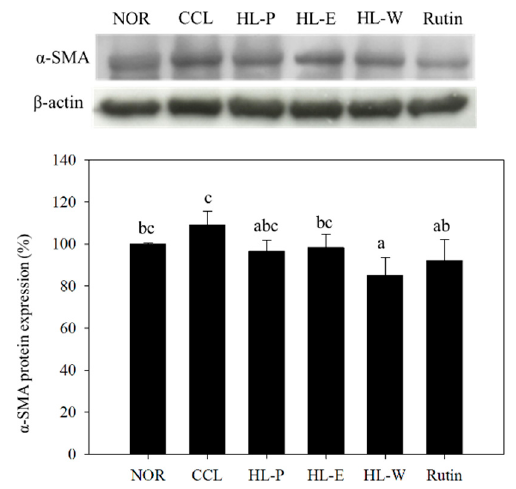
Figure 6. The effects of red quinoa and its extracts on α -SMA of CCl 4 -induced liver injury mice. NOR: normal group, CCL: CCl 4 -induced liver injury mice, HL-P: CCl 4 -induced liver injury mice fed 5.13 g/kg (rutin 8.46 mg/kg) of red quinoa-powder, HL-E: CCl 4 -induced liver injury mice fed 1.54 g/kg (rutin 16.4 mg/kg) of red quinoa-ethanol extracts, HL-W: CCl 4 -induced liver injury mice fed 1.54 g/kg (rutin 3.92 mg/kg) of red quinoa-water extracts, Rutin: CCl 4 -induced liver injury mice fed 16.4 mg/kg of rutin. Data are presented as mean ± SD (n = 8). a,b,c, Different letters indicate significantly different values according to a one-way ANOVA using Duncan's multiple test ( p < 0.05).